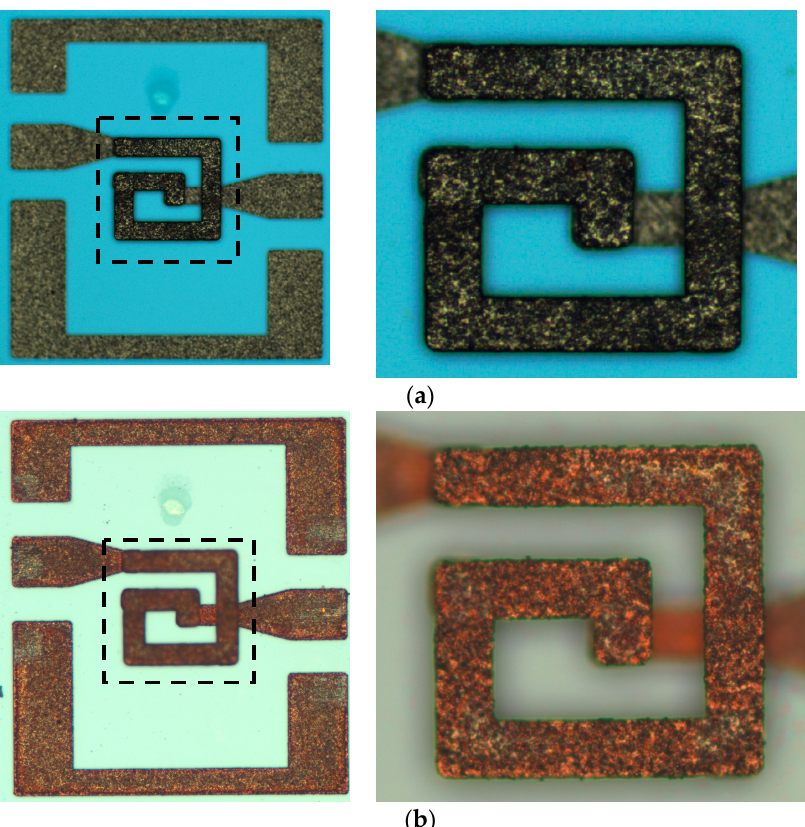
Figure 13. The intact inductor before and after 60,000 g shock test. ( a ) Before shock test; ( b ) after shock test.